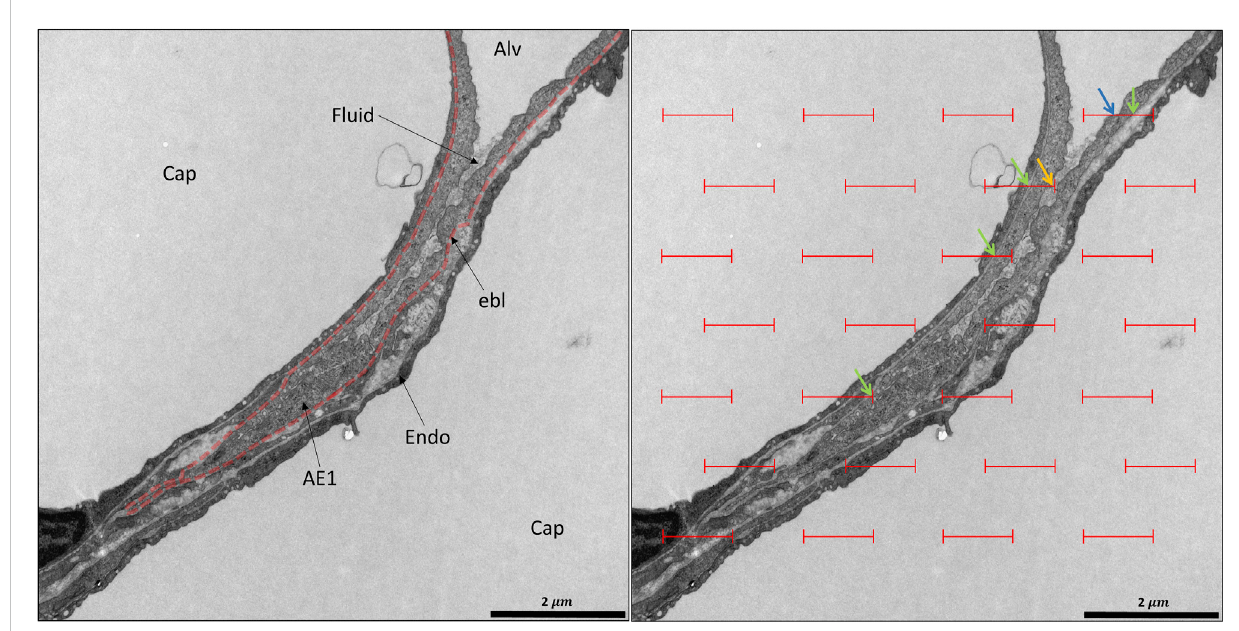
FIGURE 14 Design-based stereology of the blood-gas barrier: A healthy rat lung was fi xed in vivo by vascular perfusion via the vena cava caudalis at an airway opening pressure of10 cmH 2 Oafter two recruitment maneuvers(3 spauseat30 cmH 2 O)(Knudsen etal.,2018).In thecenter,apleat fi lled with protein- containing fl uid and bordered by the blood-gas barriers can be seen. On the left, the epithelial basement membrane (ebl) is delineated (dashed red line). While at the top right corner, the alveolar epithelium is exposed to air (Alv), the pleat hides epithelial surface area which might be recruitable on inspiration.Thepleatis fi lledbyagrayishmaterialrepresentingpreservedpartsoftheliquid-lininglayer.Inordertoquantifythesurfaceareacoveredbyair or hidden within pleats, test lines can be projected on randomized electron microscopic images for intersection counting as shown on the right. Line segmentsofacertainlengtharesuperimposedontheimage.Theprobabilityoftheselinesegmentstointersectaircoveredorhiddenalveolarepithelium is proportional to the collective length (L) of the line segments but also to the surface density of, e.g. air-covered or hidden alveolar epithelium. Hence, intersection (I) counting can be applied to determine the surface density (Sv) of the desired structures, given by the equation Sv = 2*I/L. Intersections are indicatedasfollows:bluearrow:air-coveredalveolarepithelialsurfacearea;yellowarrow:hiddenalveolarepithelialsurfacearea.Thesamelinesegments can be used to determine the surface area of the epithelial basement membrane, a parameter eligible to quantify stretch of the blood-gas barrier. The green arrows point at intersections of the line segments with the epithelial basement